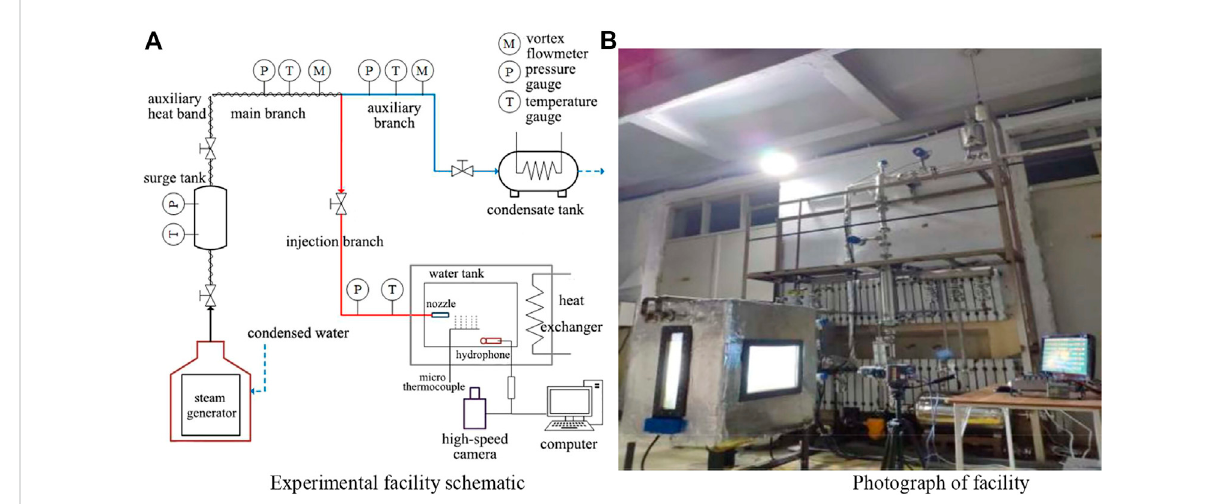
FIGURE 1 Schematic of the experimental system. (A) Experimental facility schematic. (B) Photograph of the facility.